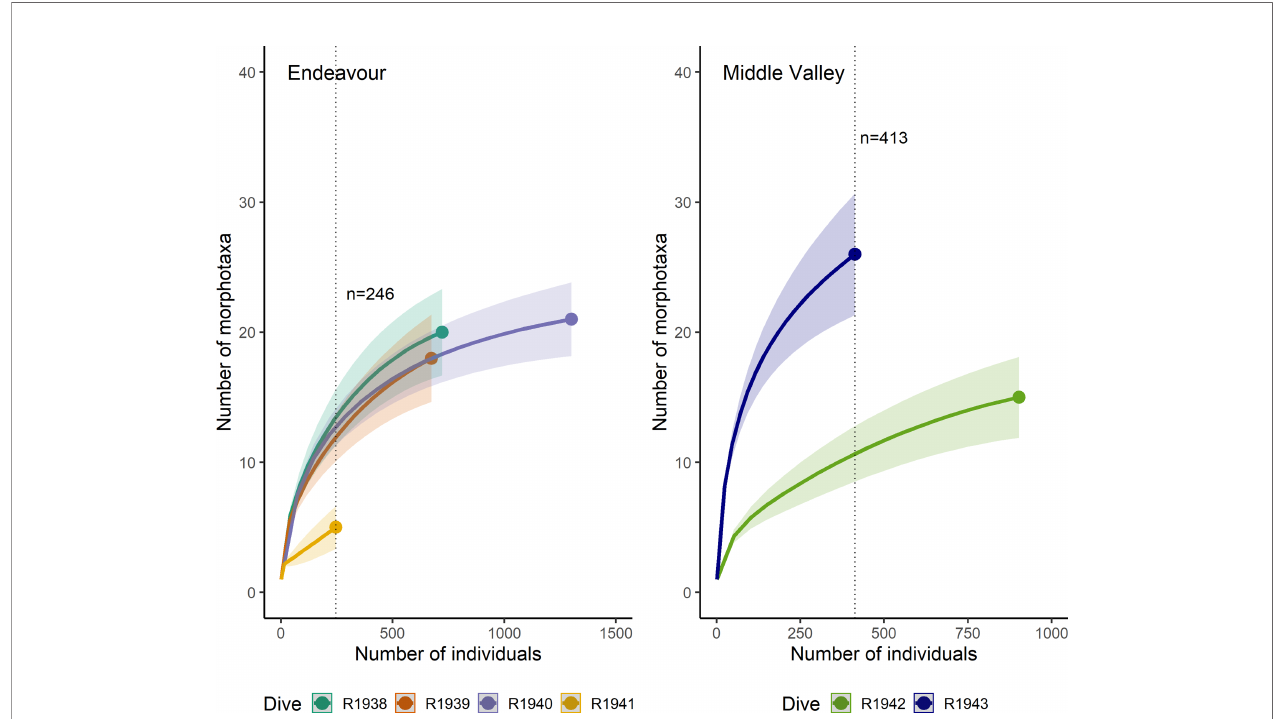
FIGURE 10 | Individual-based rarefaction curves for the dives at Endeavour (R1938-R1941) and Middle Valley (R1942 and R1943). The dotted vertical line indicates the minimum number of individuals sampled across all dives at each